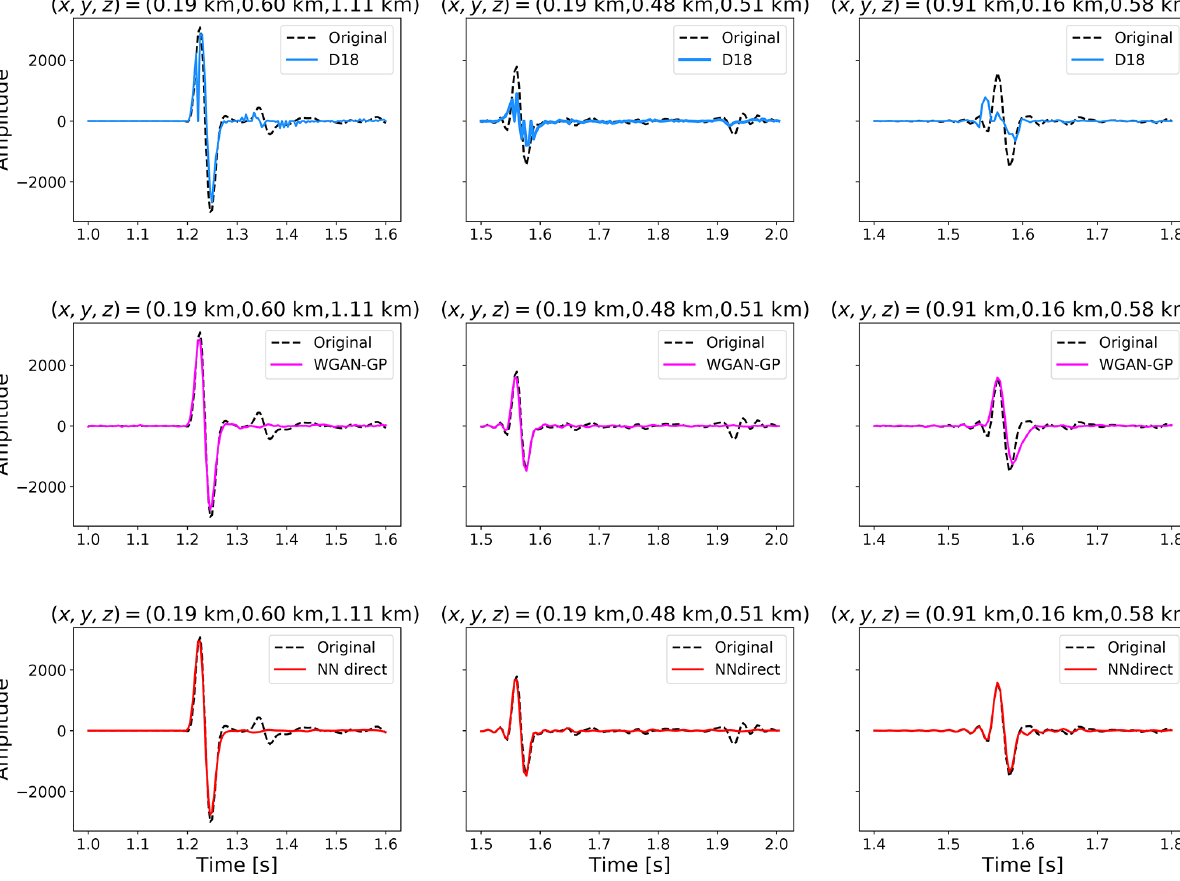
ond and third column in Fig. 8). The WGAN-GP and